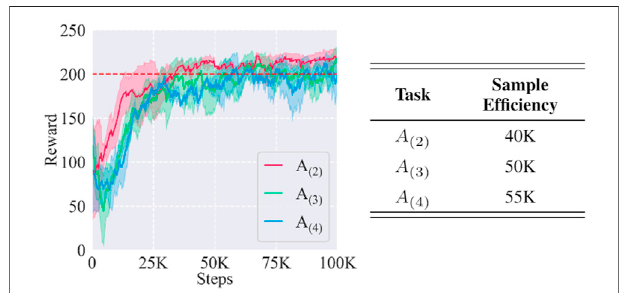
FIGURE 7 | Learning curves and sample ef fi ciencies of task instances A (2) , A (3) , and A (4) . The red dashed line represents the near-optimal reward.